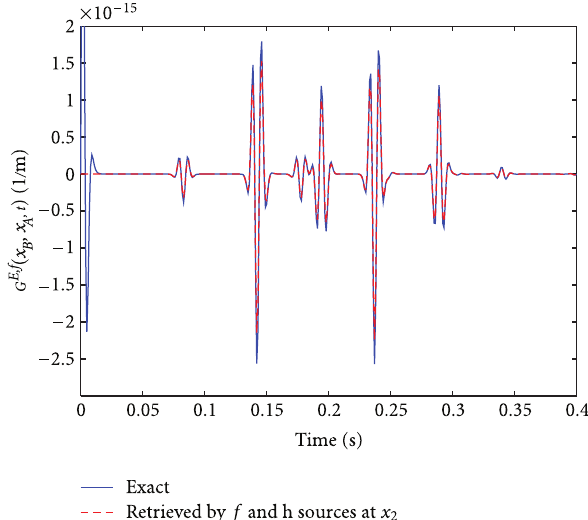
Figure 16: Comparison between the exact Green’s function G E , f ( x B , x A , t ) and the Green’s function retrieved by considering only seismic boundary source contributions in the right-hand side of (52). In other words, the contributions of the domain sources and electromagnetic boundary sources are neglected. As can be seen, the amplitude errors between the exact and retrieved Green’s functions are acceptable (about 10% or less). Because only the Green’s function corresponding to the positive time window is con- sidered here, no spurious events (which reside in the negative time window) are